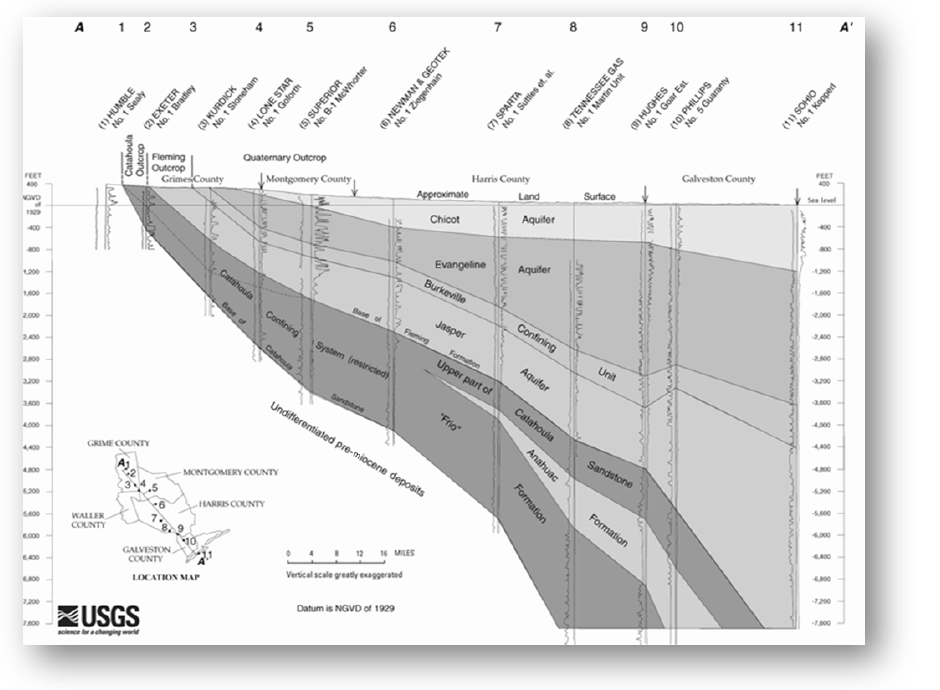
Figure 1. Hydrogeologic cross-section of the Gulf Coast aquifer system in the Houston Region, Texas, USA (modified from Kasmarek,